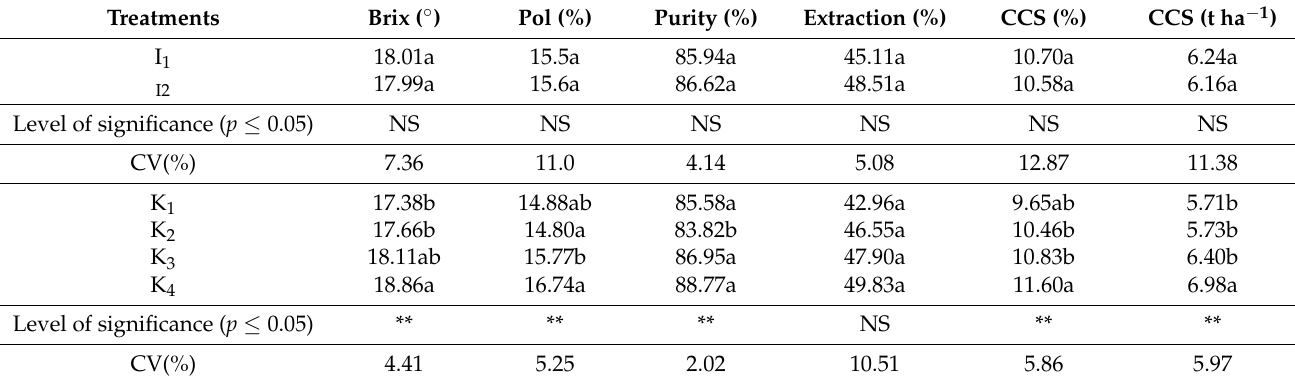
Table 3. Quality parameters of sugarcane at 8 months after harvest at different irrigation and potassium levels.